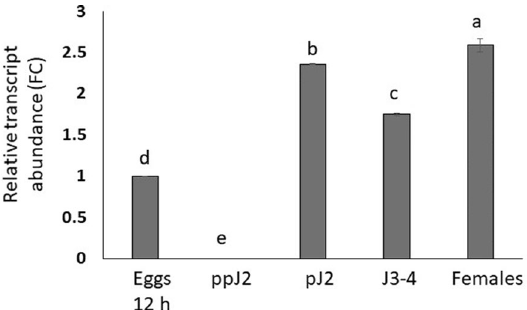
Figure 2. MjMCM2 expression pattern throughout M. javanica ’s life cycle. MjMCM2 transcripts from five different nematode developmental stages (eggs, preparasitic (pp) J2s, parasitic (p) J2s, J3–4s, and mature females) were subjected to qRT-PCR analysis. The transcripts were normalized against two endogenous nematode reference genes, 18S and EF-1α . Each reaction was performed in triplicate and results represent the mean of three replicates of one independent biological replicate. Data represent the mean relative expression and standard error obtained from one independent biological experiment. Different letters above the bars denote a significant difference ( P ≤ 0.05, ANOVA) between samples by Tukey–Kramer multiple comparison test. The experiment was repeated twice for each housekeeping gene and similar results were obtained.